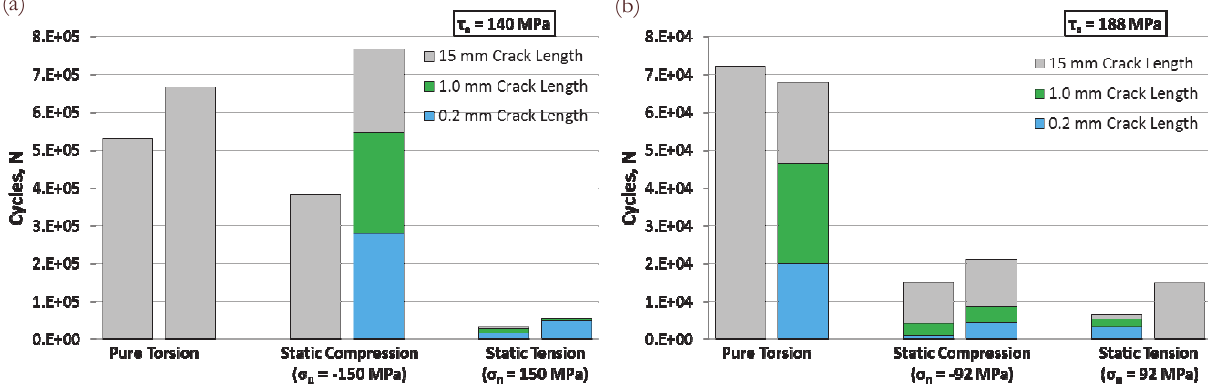
Figure 4: Fatigue lives to various crack lengths for smooth specimens tested at shear stress amplitudes of (a) 140 MPa and (b) 188 MPa with and without static axial stresses. Specimens for which no crack growth data were available are shown as solid gray